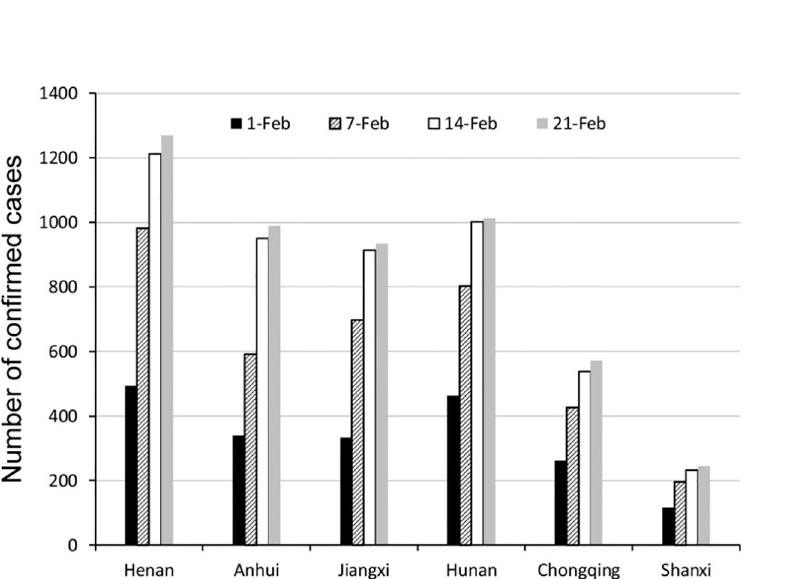
Fig 5. The change of NCCC in 6 provinces from February 1 to 21. (figure was drawn by author).